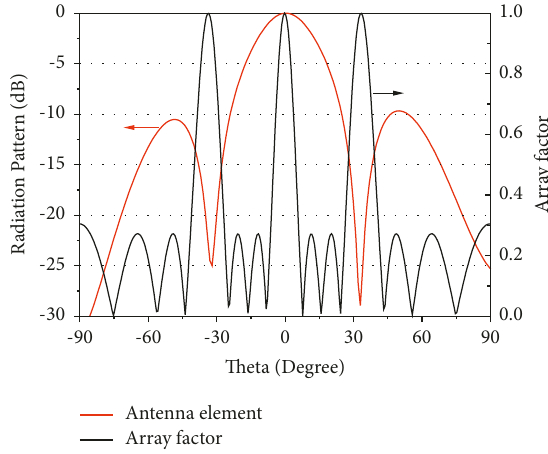
Figure 5: Simulated | S 11 | of the slotted SIW cavity.